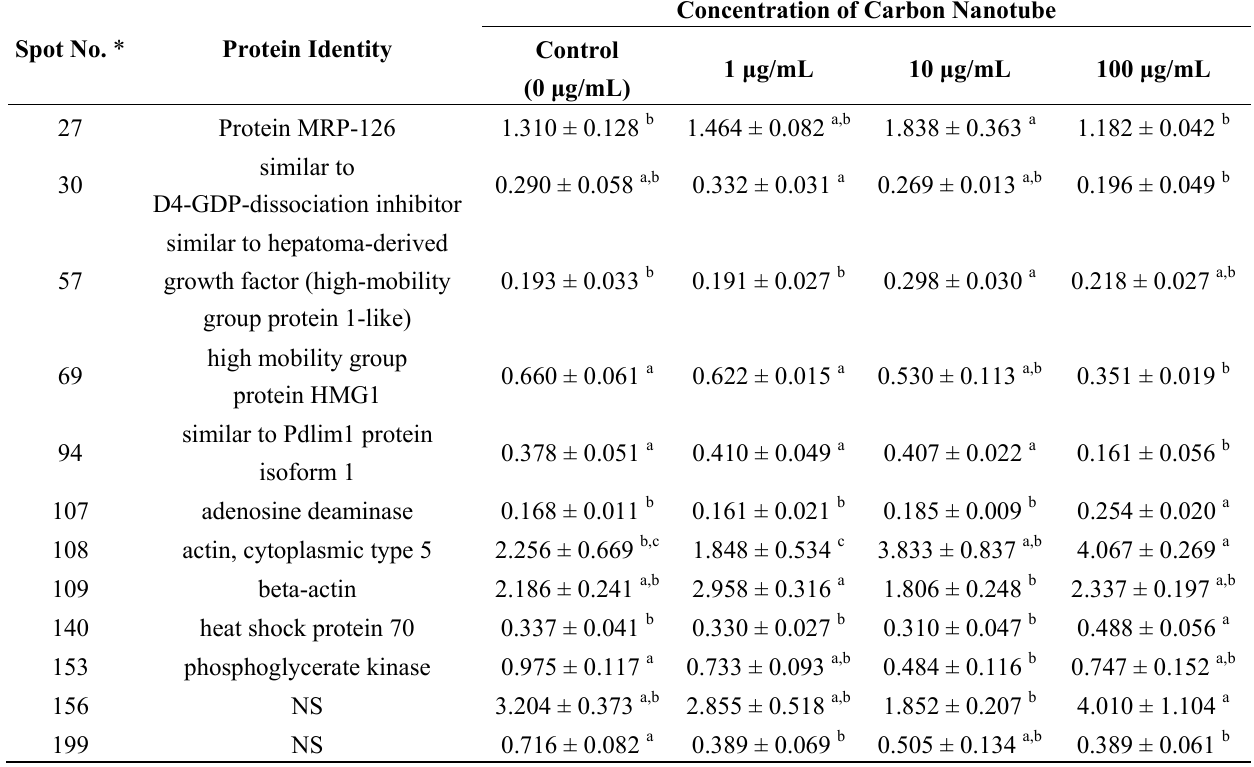
Table 1. Differentially expressed protein spots in carbon nanotube-treated chicken macrophages. #